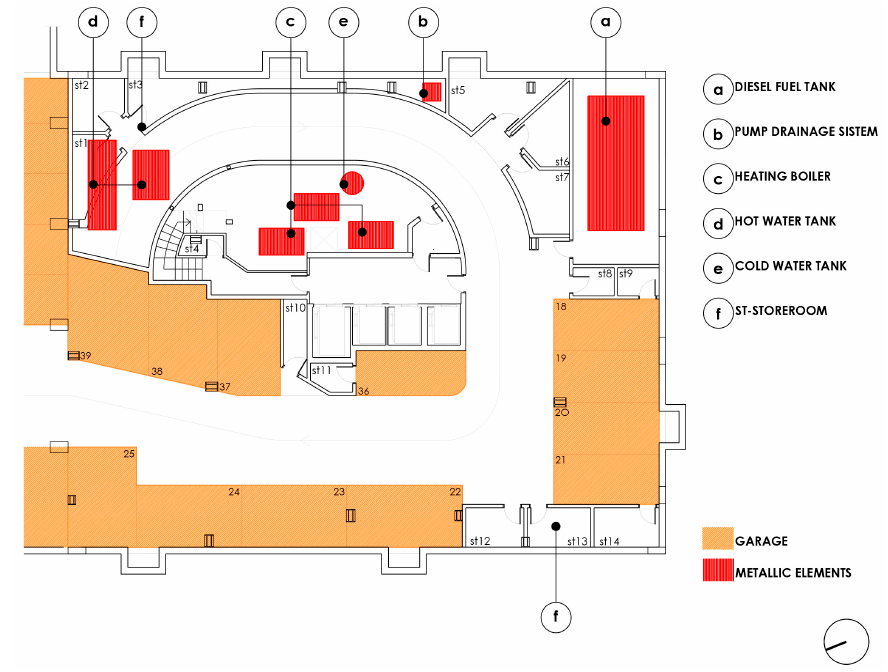
Figure 2. Basement level − 2 plan.